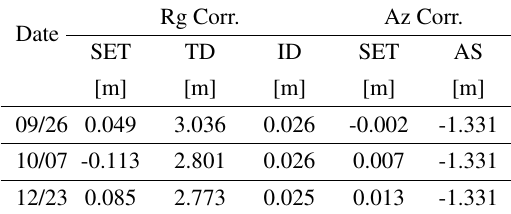
Table 2. Observation corrections in